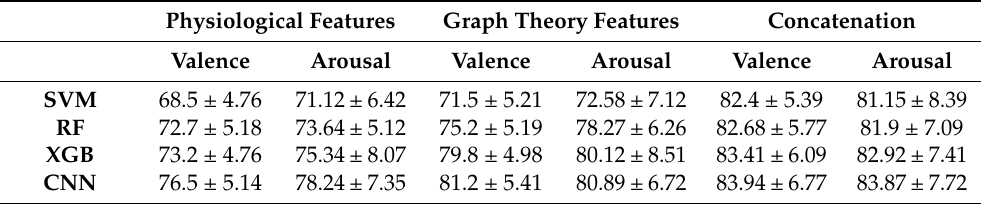
Table 2. Accuracy results from the experimental analysis of all subjects (mean ± standard deviation) using different feature sets. The first column pair represents the results of the peripheral physiological feature set, the second pair represents the results of the graph theory feature set and the last column pair includes the results of the concatenation of these feature